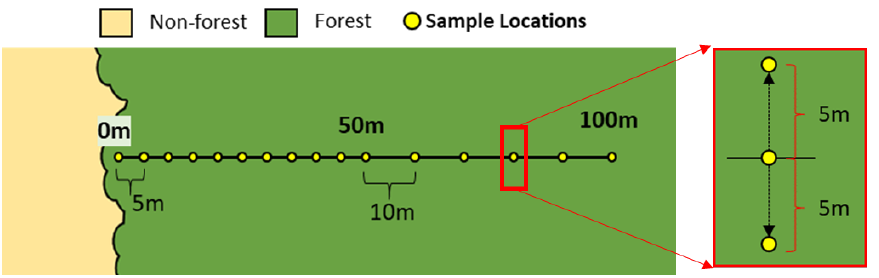
Figure 2. Ground sampling setup along transects.